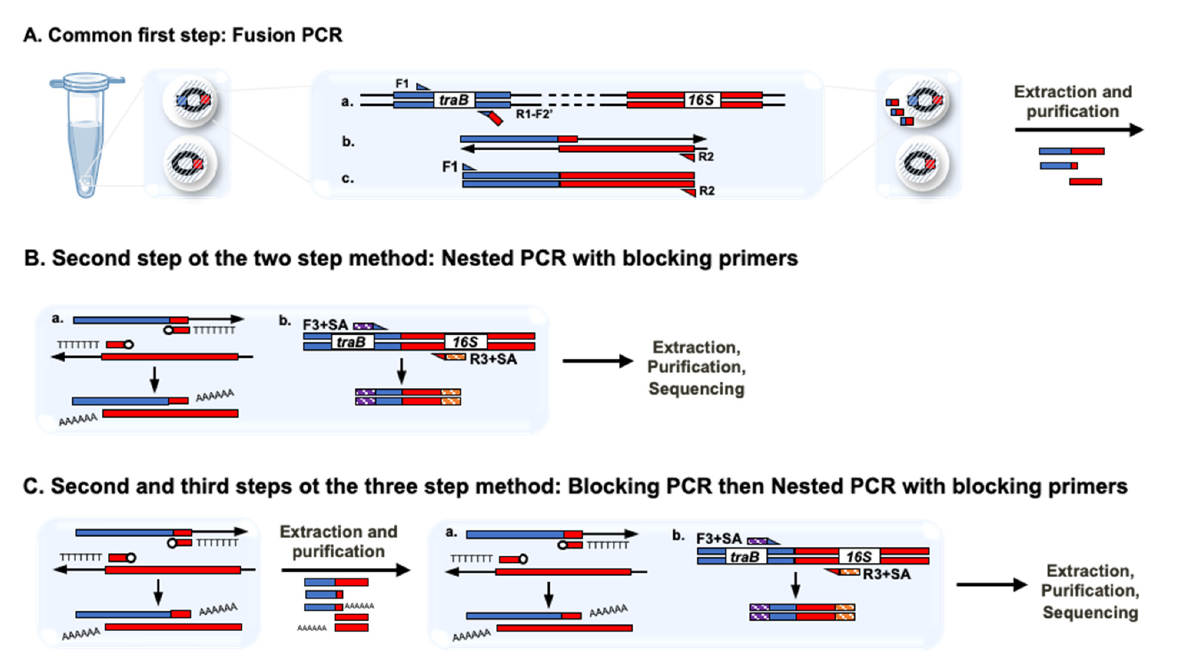
Figure 2. Principle of the two- and three-steps epicPCR protocols implemented. ( A ) Fusion PCR in polyacrylamide beads. (a) Amplification of the traB gene fragment using F1 and R1-F2 ′ primers. The latter is added at limited concentration and will serve as forward primer for (b) the 16S rDNA gene fragment amplification. (c) Finally, F1 and R2 primers amplify the fused product. ( B ) Nested PCR with blocking primers. (a) Blocking of unfused fusion PCR products using BPs at 3.2 µM, along with (b) a nested PCR on fused products using F3 + SA and R3 + SA primers carrying sequencing adaptors (SA). ( C ) Blocking PCR then Nested PCR with blocking primers. Unfused products were first blocked using only BPs at 3.2 µM, before performing a PCR where (a) potentially residual unfused products were blocked using blocking primers at 0.32 µM, along with (b) a nested PCR on fused products using F3 + SA and R3 + SA primers.